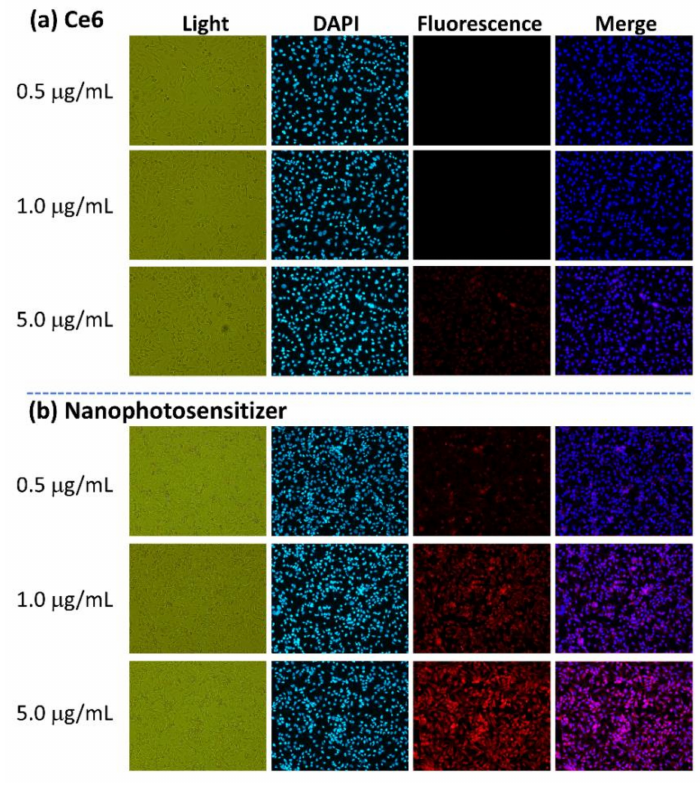
Figure 7. Fluorescence observation of the HeLa cells with treatment using the Ce6 ( a ) and the nanophotosensitizers ( b ). Treatment was similar to Figure 6. Magnification: ×